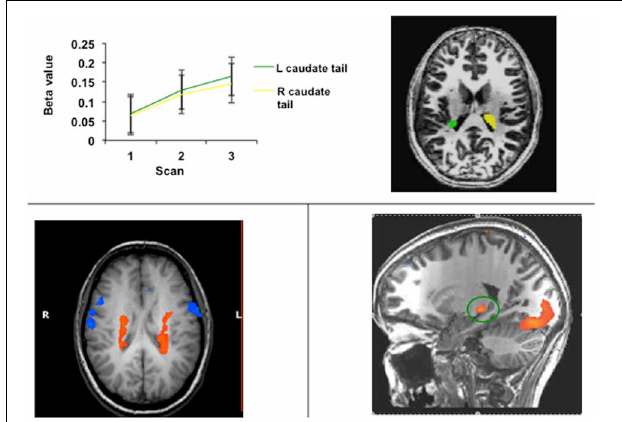
FIGURE 6 | Activity in the tail of the caudate nucleus in functional imaging studies of categorization and related learning tasks. (Top) Regions of the right and left caudate tail that increased in activity across blocks of learning; data from Seger et al. (2010) (Bottom left) Bilateral region of the body and tail of the caudate active during learning of both probabilistic and deterministic stimulus-category relationships. Data adapted from Seger and Cincotta (2005). (Bottom right) Region of the caudate tail (green circle) that was more active during the stimulus-response portion of categorization trials than during the feedback receipt portion; data from Lopez-Paniagua and Seger